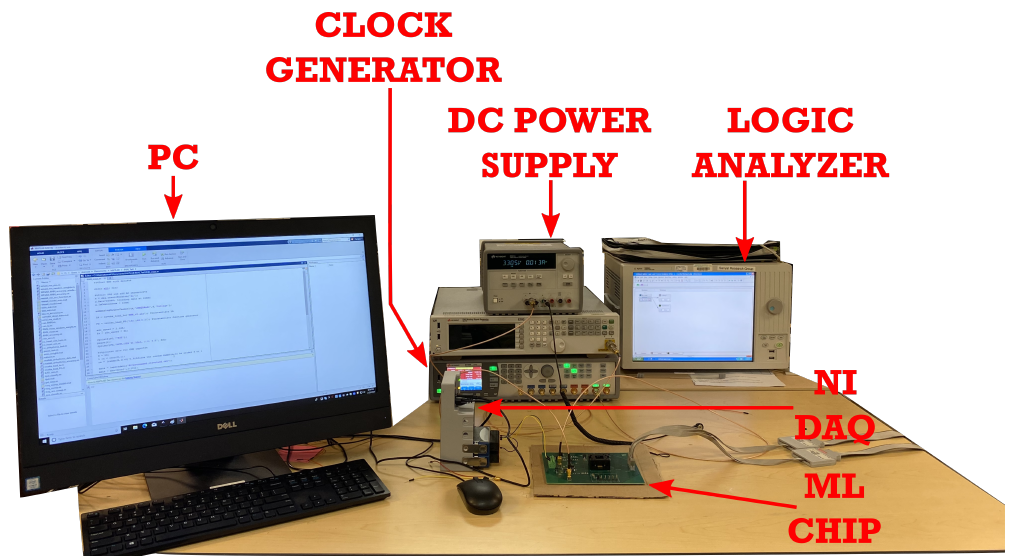
Figure 8. Test setup used to validate proposed classifier.